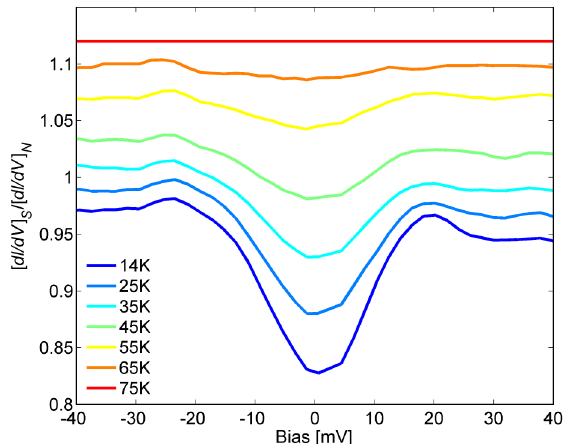
FIG. 2. Measured AC differential conductance below T c ½ dI=dV (cid:4) S , divided by the normal-state conductance for the Bi-2212/GaAs junction at various temperatures. The curves are shifted vertically for clarity by 2%, and the vertical axis corresponds to the 14-K